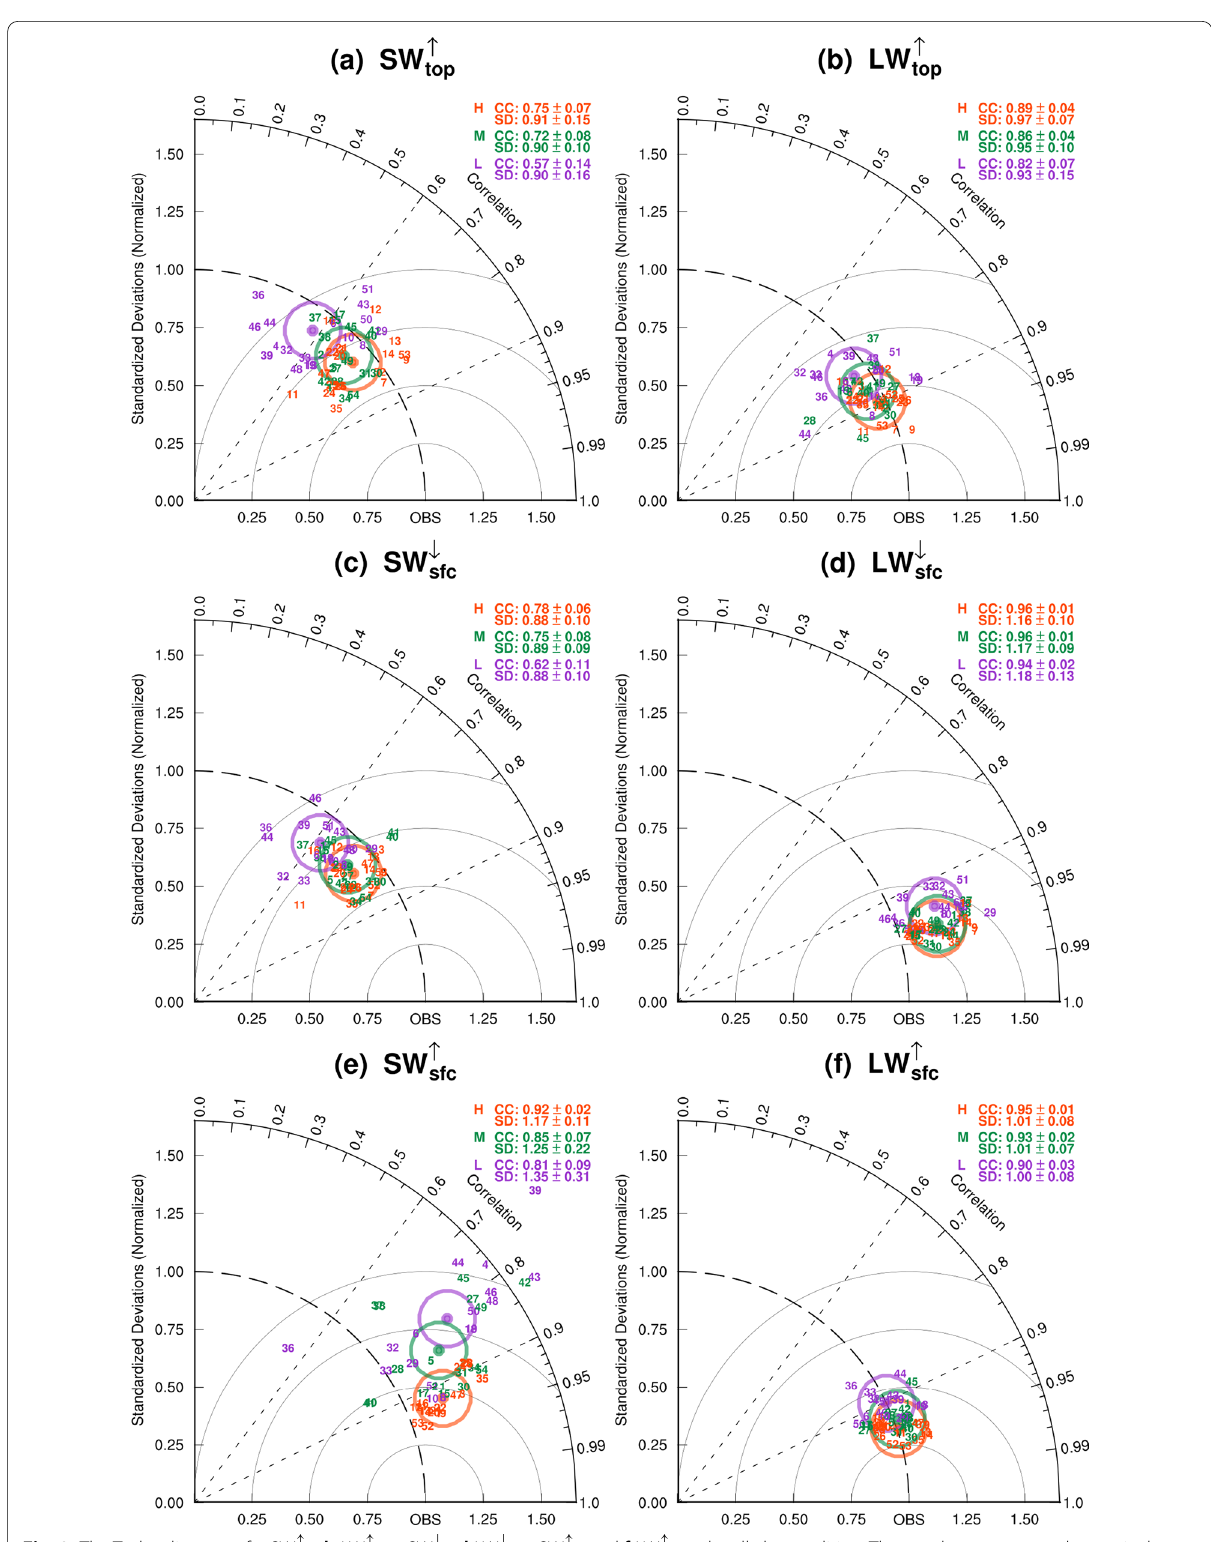
Fig. 2 The Taylor diagram of a SW ↑ top , b LW ↑ top , c SW ↓ sfc , d LW ↓ sfc , e SW ↑ sfc , and f LW ↑ sfc under all‑sky condition. The number represents the particular model listed in Table 1. The orange, green and purple circles denote the ensemble means of high‑, medium‑ and low‑resolution groups, respectively. The statistical information of the six radiative fluxes for three different groups of CMIP6 models is presented at the top‑right